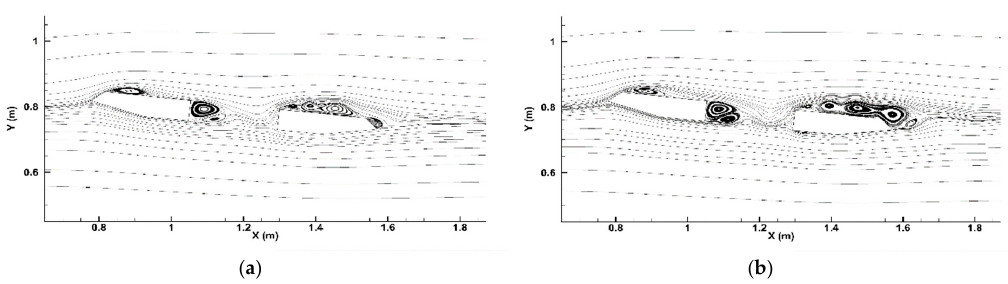
Figure 11. Instantaneous streamlines of AoA = + 6.3 ◦ at ( a ) tU ∞ / D = 304 and 2 tU ∞ / b = 69, and ( b ) tU ∞ / D = 368 and 2 tU ∞ / b =